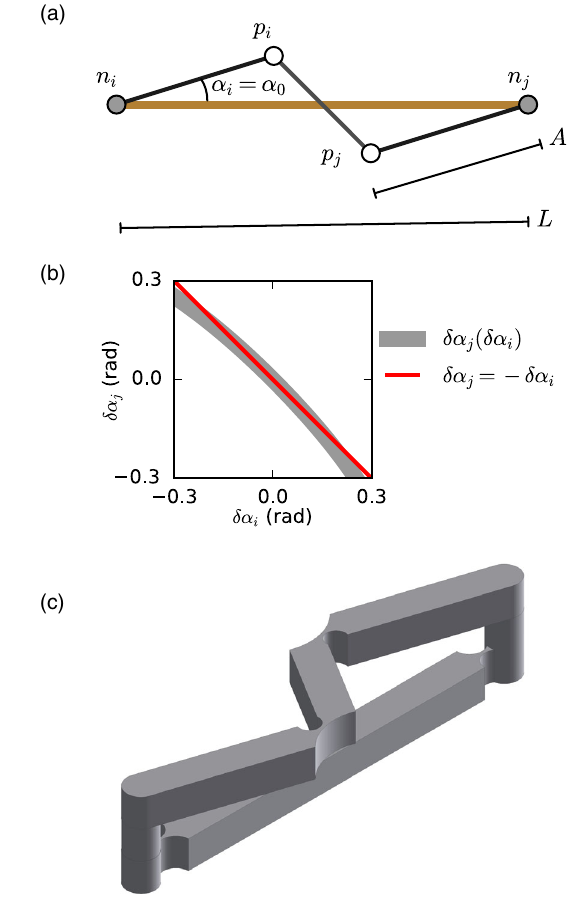
FIG. 8. An alternative to the geared link. (a) The link constrains the motions of freely pivoting nodes n i , n j (gray disks); it is symmetric under in-plane rotations by π rad. The nodes are connected by a rigid beam of length L (orange line). Node n i is connected to subnode p i (white disk) by a rigid subbeam (black line) of length A at an angle α 0 . Subnodes p i , p j are intercon- nected by a rigid subbeam of length l (gray line). The beam of length L constrains the distance between nodes n i , n j , and the subbeam mechanism ensures that the nodes counterrotate in the linear regime. (b) Numerical calculation of the relationship between deviations δα i , δα j from the angle α 0 at nodes n i , n j (gray line), for the link design shown in (a). Here, α 0 ¼ 0 . 3 rad and A=L ¼ 0 . 4 . In the linear regime, the relationship shows excellent agreement with δα j ¼ − δα i (red line), which describes pure counterrotation of the nodes. (c) A possible continuum 3D design for the link. Thin hinges accommodate low-energy pivoting at nodal points within the